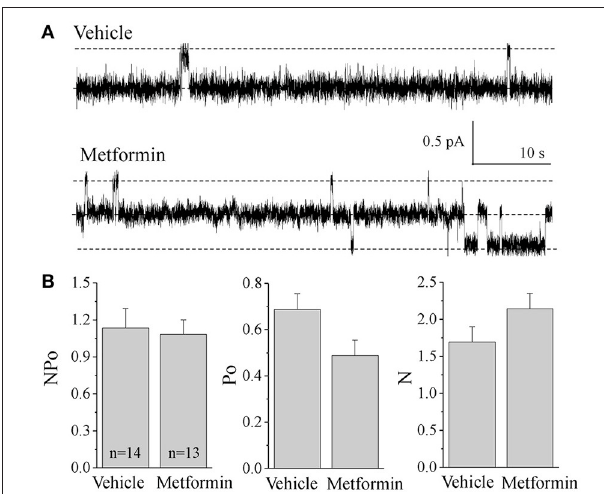
FIGURE 4 | ENaC activity in cortical collecting ducts of vehicle- and metformin-infused animals. (A) Representative current traces for ENaC activity measured in cell attached patches from freshly isolated CCDs. Rats were fed with 8% salt diet and treated with either vehicle ( N = 3) or metformin ( N = 5). Holding potential was –40 mV. (B) Summary graph of observed ENaC activity ( NP o ), open probability ( P o ) of individual channels and number of channels ( N ) in the